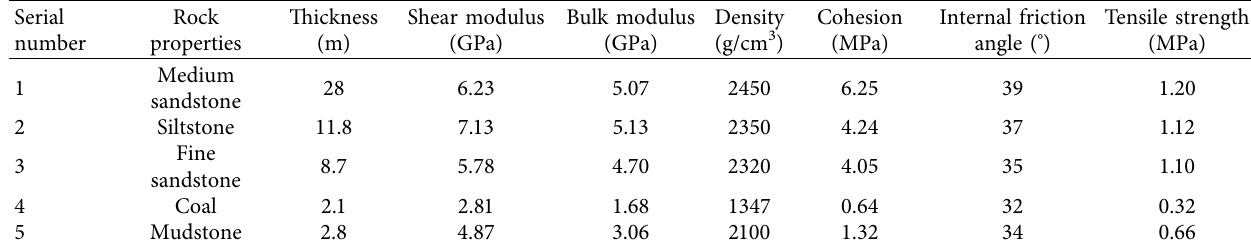
Figure 1: A failed support and hydraulic pipe explosion. Table 1: Rock mechanics parameters.